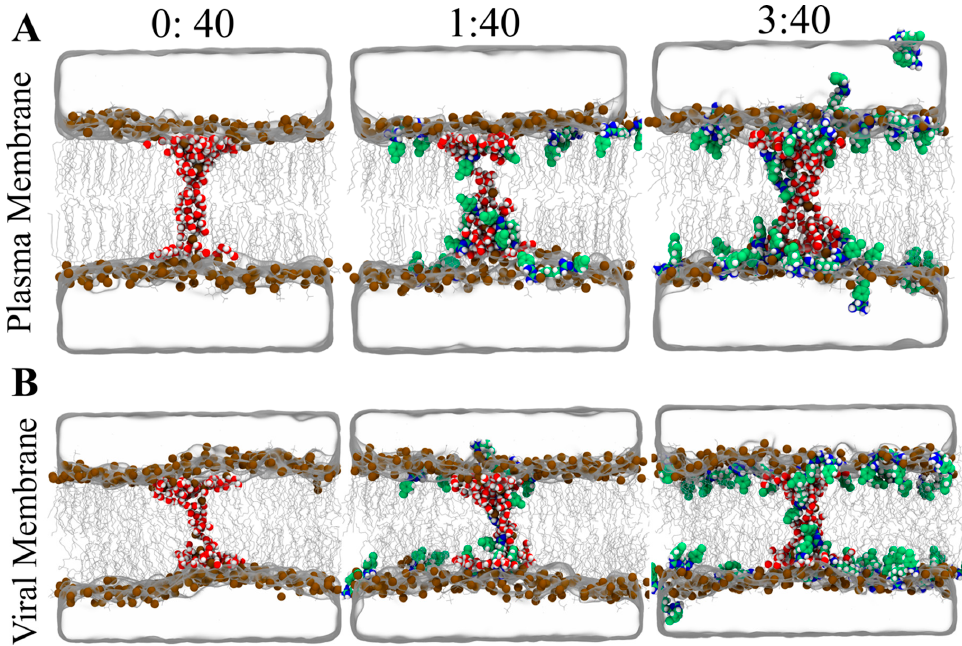
Figure 6. MD simulation snapshots of pore formation at ξ = 1 for CHX:Lipid ratios 0:40, 1:40 and 3:40. ( A ) Pore formation snapshots in PM and ( B ) Pore formation snapshots in VM. Figures are rendered as described in Figure 2A,B.